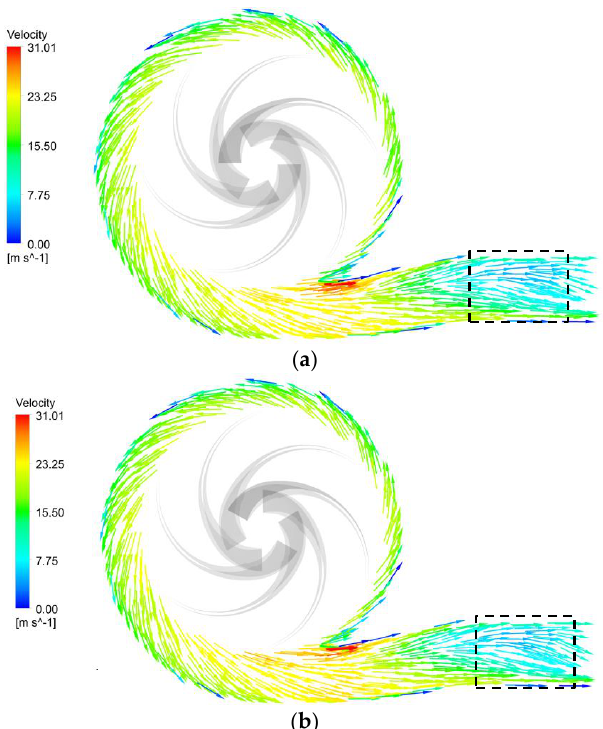
Figure 29. Velocity vector distribution on the middle section of the discharge chamber under Q 1.4 : ( a ) Impeller phase at 0°; ( b ) Impeller phase at 30°.